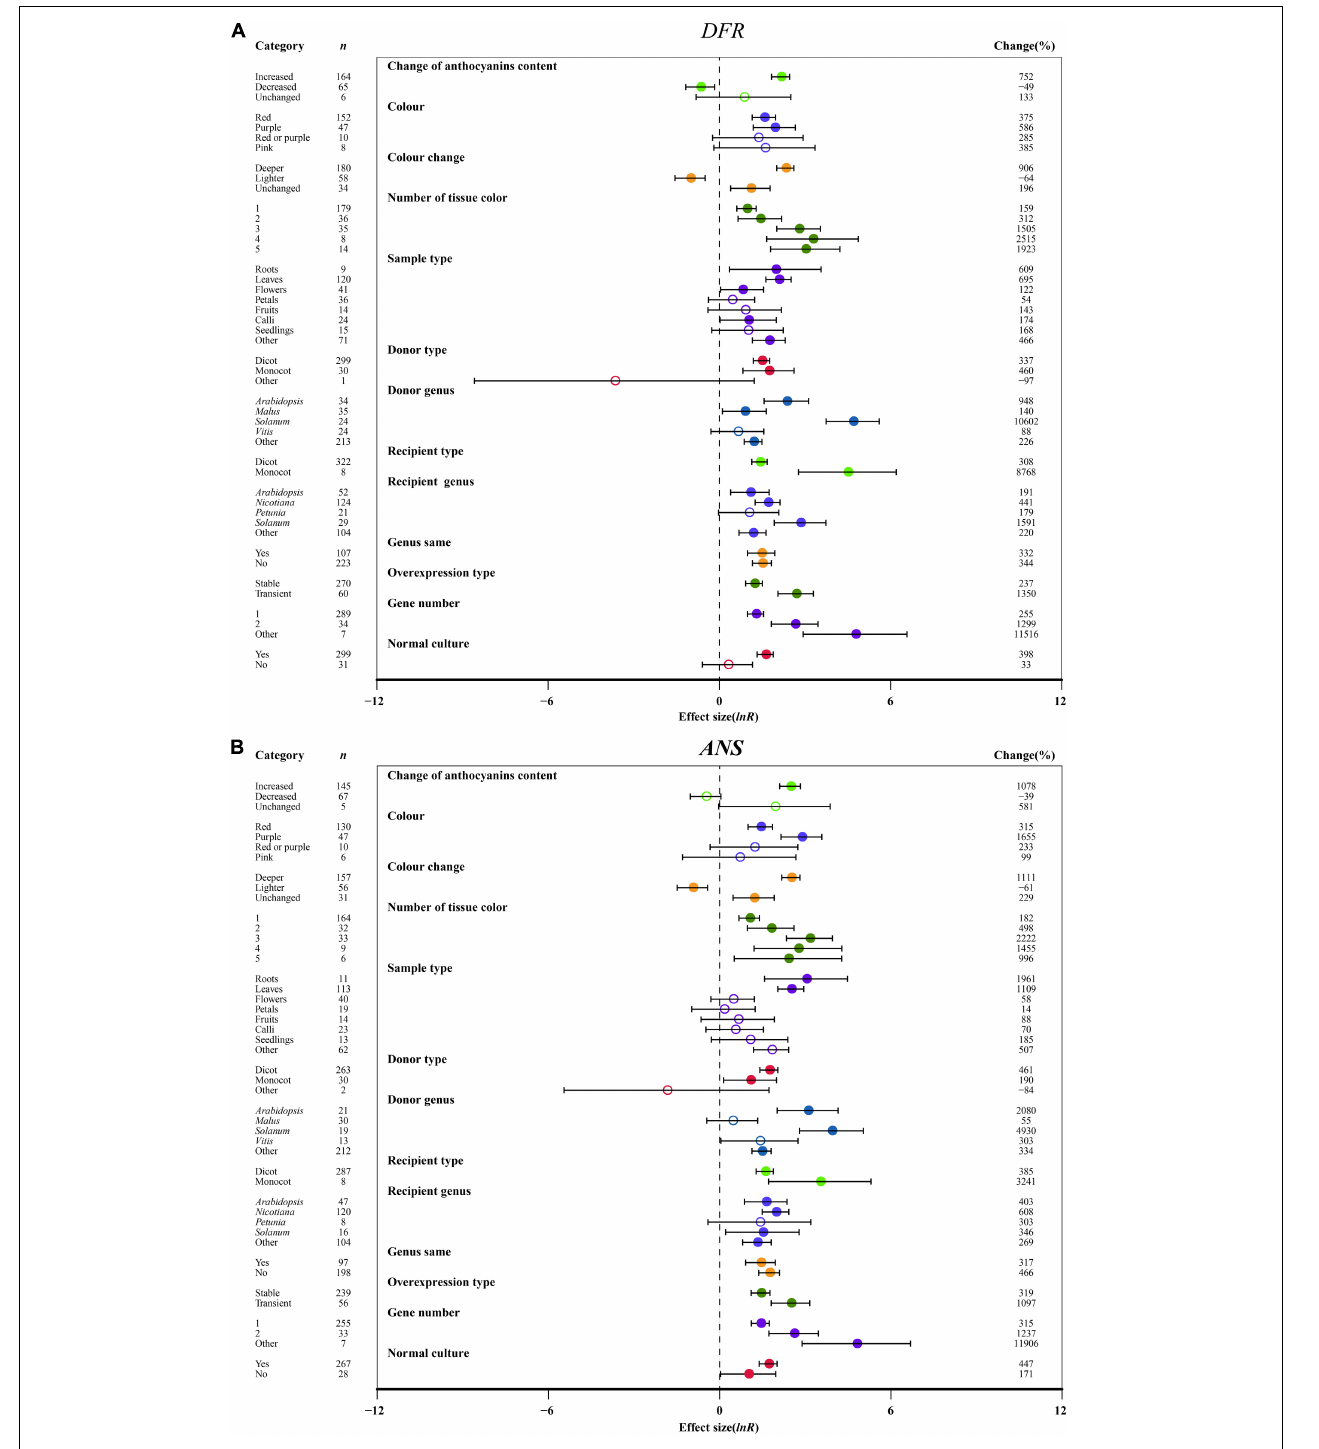
FIGURE 7 | Summary effects (ln R ) of the influence of MYB overexpression on the expression of DFR (A) and ANS (B) in plants. Ratios are unit-less. The ratios illustrate the strength of MYB overexpression on the summary effects of the expression of DFR and ANS compared with the controls. Circles and horizontal bars indicate the summary effects and the 95% CI of thirteen moderator variables, respectively. n represents the number of studies. Subgroup list levels (subgroups or categories) of each moderator. The percent change (to the right of plots) refers to the raw percentage increase or decrease in the expression of DFR and ANS induced by overexpression of MYB . The moderator variables of the examined plants are colored and distinguished by different colors. Closed and open circles indicate the effects of significance and insignificance, respectively.